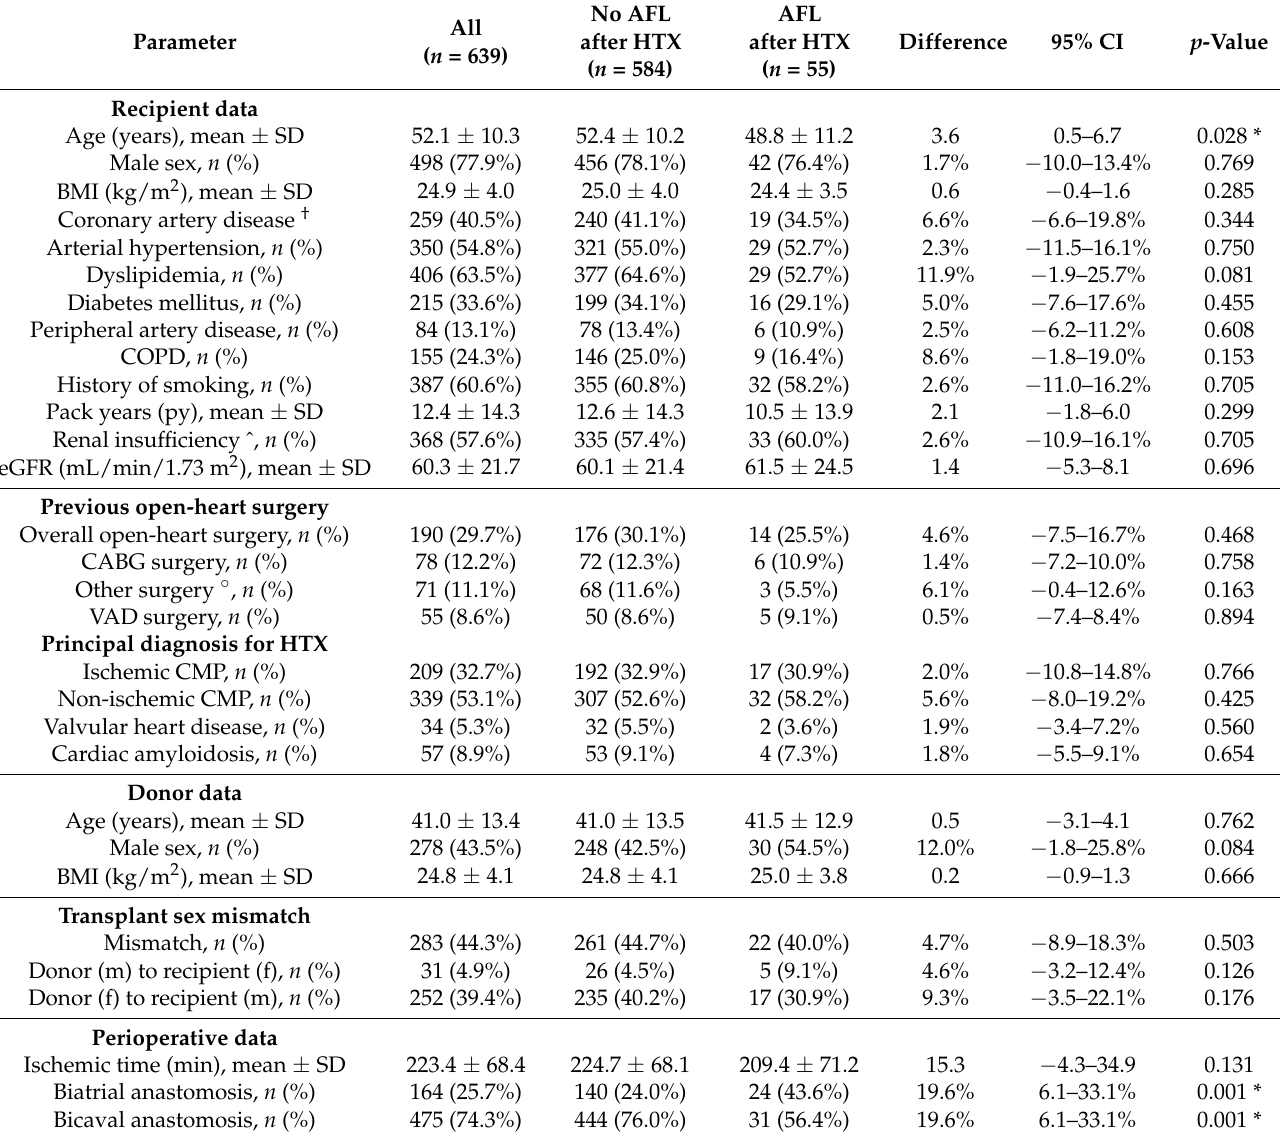
Table 1. Demographics-stratified by late-onset AFL after